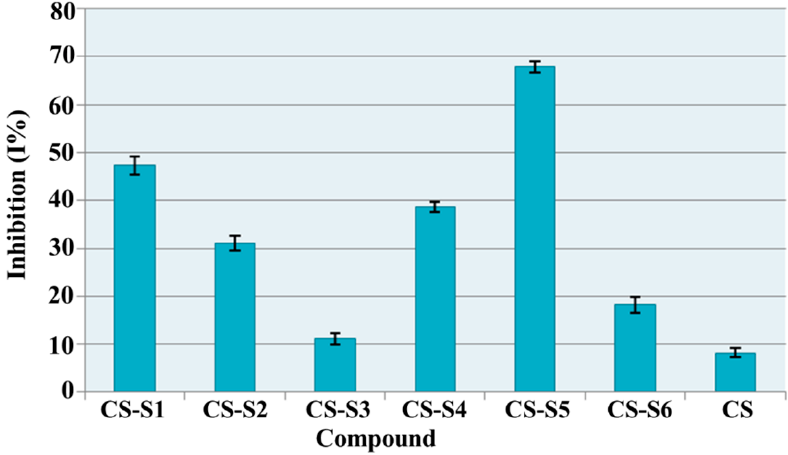
Figure 10. DPPH (1,1-diphenyl-2-picrylhydrazyl) radical scavenging ability (I %) of chitosan derivatives.